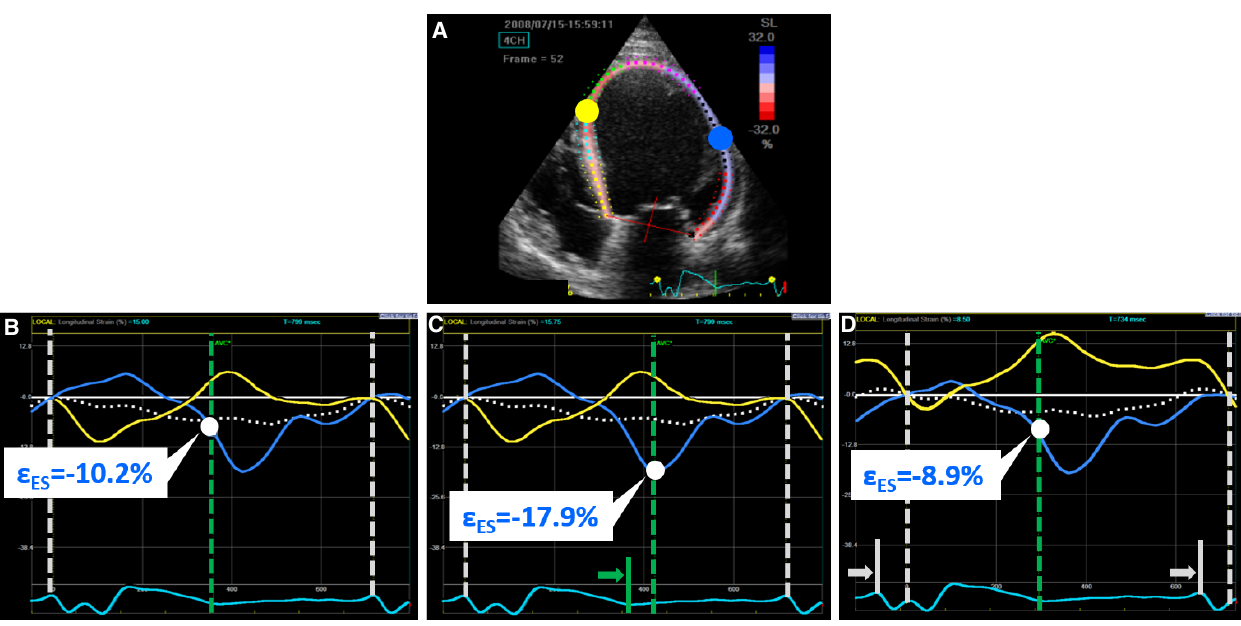
Figure 1. End-systolic strain variability due to changes in timing definitions. A ) Speckle tracking longitudinal strain in a dilated ventricle with left bundle branch block. The yellow and blue dot indicate the origin of the strain curves of the same colour in the lower panels, where in addition a dotted white curve represents global longitudinal strain. ( B ) Correct definition of end-diastole (ED) and end-systole (ES). ( C ) The definition of ES has been moved by + 4 frames (green arrow indicates initial ES; green dashed line indicates current ES). Note the impact on the measured systolic strain value. ( D ) Here, the definition of ED has been moved by + 4 frames (white arrow indicates initial ED; white dashed line indicates current ED). Also, in this case, the measurement of end-systolic strain is indirectly affected due to a shift in